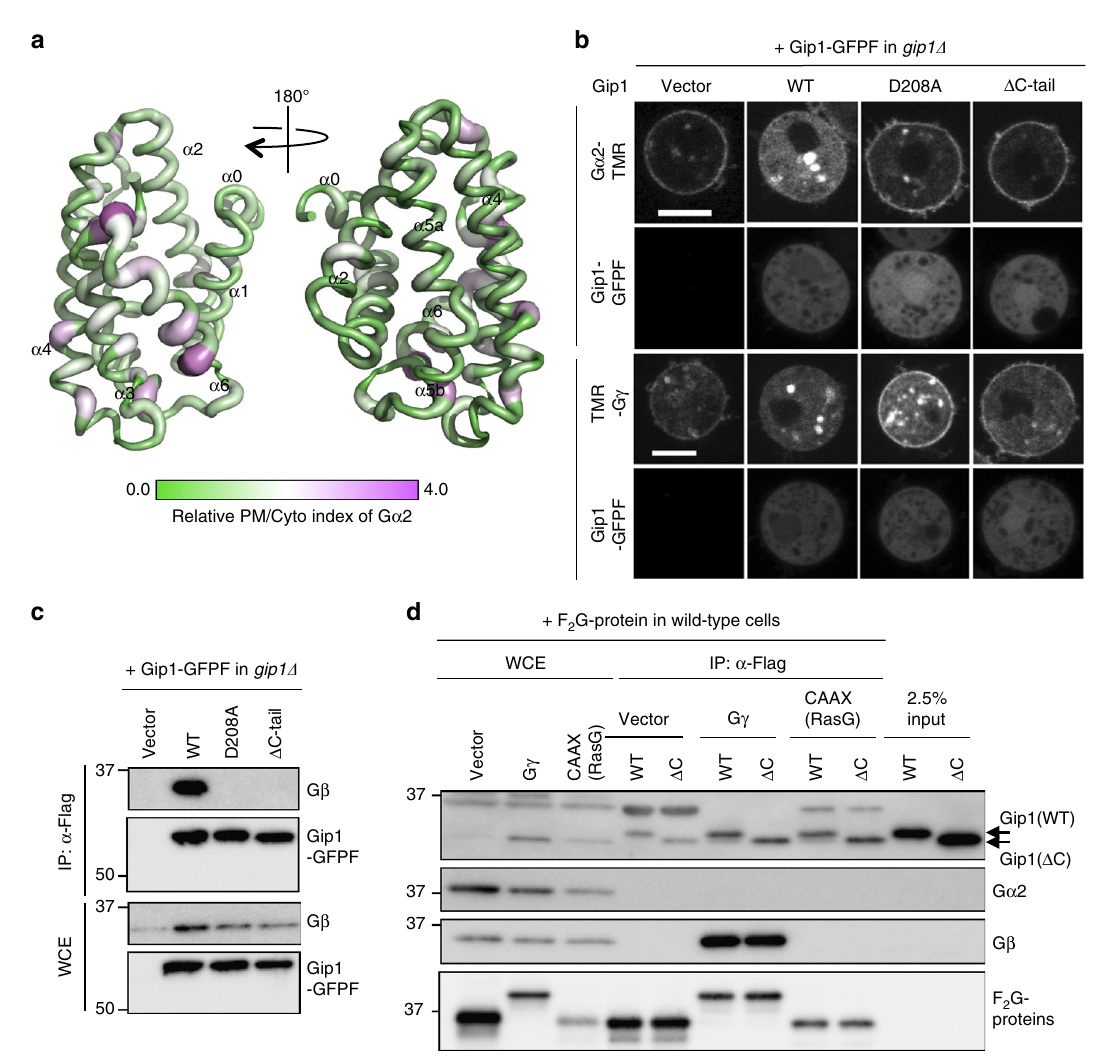
Fig. 6 Comprehensive alanine mutagenesis scan of Gip1(146 – 310). a Structural mapping of the alanine mutagenesis scan of Gip1(146 – 310). Relative plasma membrane (PM)/cytosol (Cyto) indexes were normalized by the wild-type value and mapped onto the structure. The values range from purple (strong) to green (weak), represented by both the colour and the thickness of the ribbon diagram. b Subcellular localization of G α 2 and G γ labelled with TMR and Gip1- GFPF in the presence of LatA. Δ C-tail, deletion of a.a. 304 – 310 of Gip1. Scale bar, 5 μ m. c Co-immunoprecipitation of Gip1 with G βγ . d In vitro interactions of puri fi ed Gip1. Flag-tagged GFP (F 2 G) as a vector (V), F 2 G-G βγ , and F 2 G containing the CAAX box (a.a. 178 – 189) from RasG were bound to beads